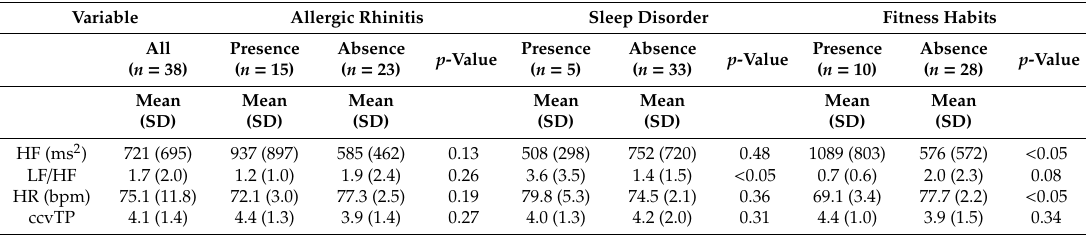
Table 2. Baseline heartrate variability data in the overall sample and by health condition; statistical significance is of participant’ t -test results ( n =